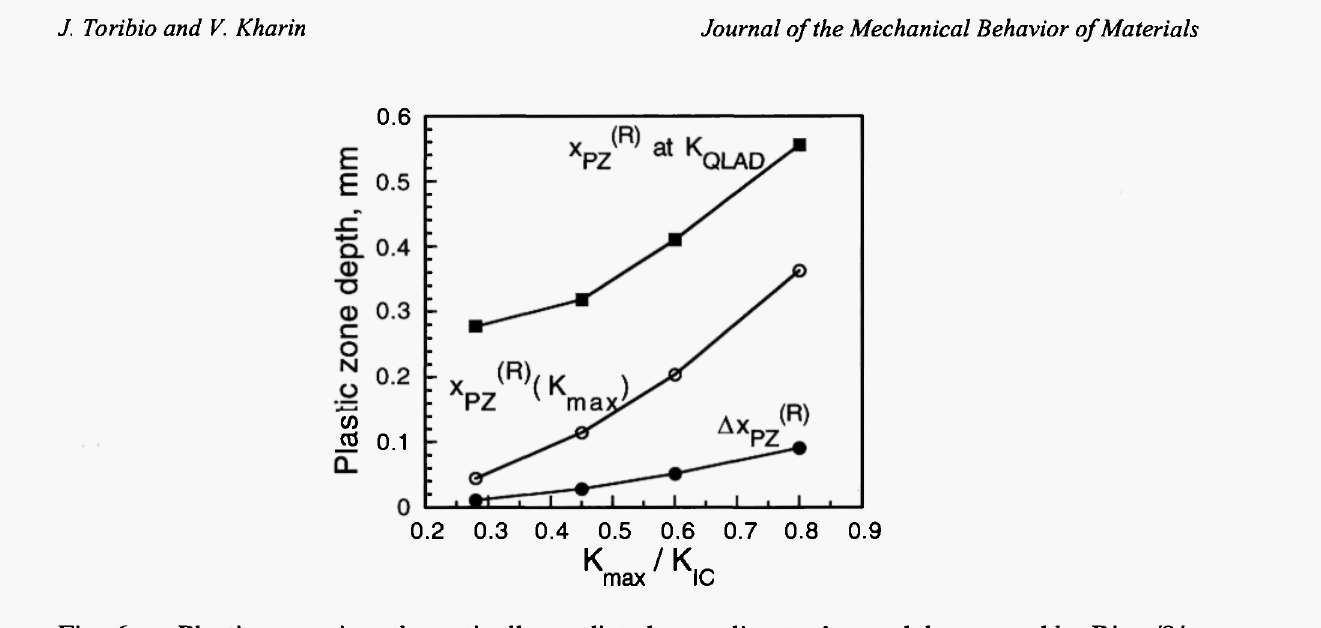
and cyclic for K=K and at ma x m j n )